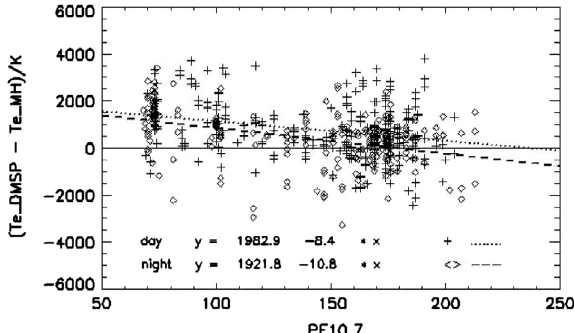
Fig. 6. Difference between DMSP probe Te measurements and simultaneous Millstone Hill incoherent scatter measurements versus the solar activity index PF10.7 = (F10.7D + F10.7_81)/2 with F10.7D the daily solar radio flux index F10.7 and F10.7_81 the 81 day average of F10.7. The 540 coincidences from the time period 1996 to 2006 are separated into daytime (+) and night-time ( e ) and also include a least-square fitted linear approximation (broken curve) with the formula given at the